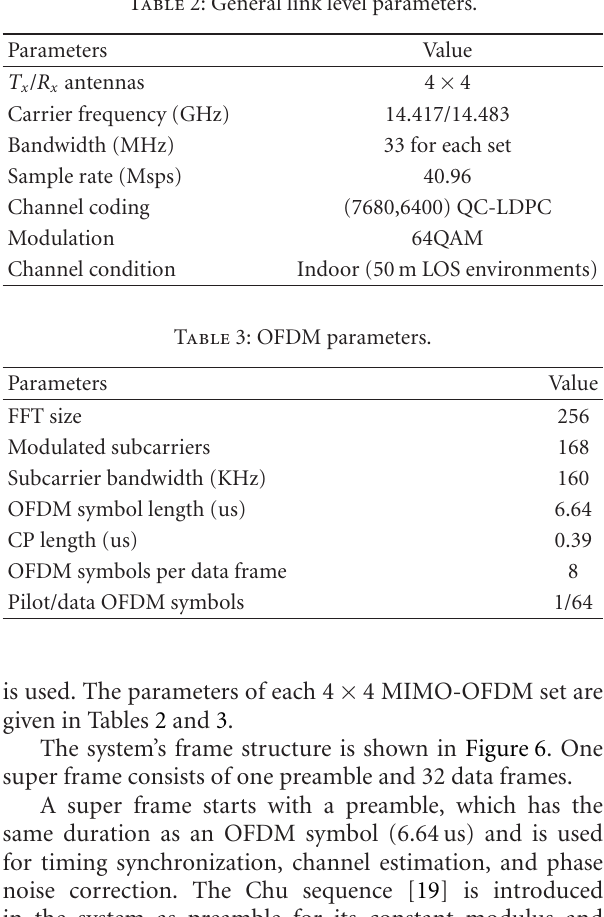
Table 2: General link level parameters.